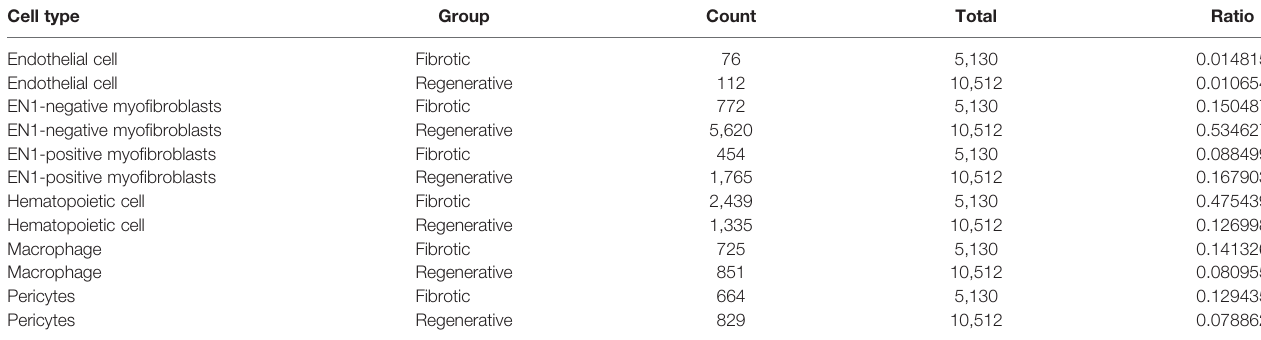
TABLE 1 | Cell ratio of each cell type.